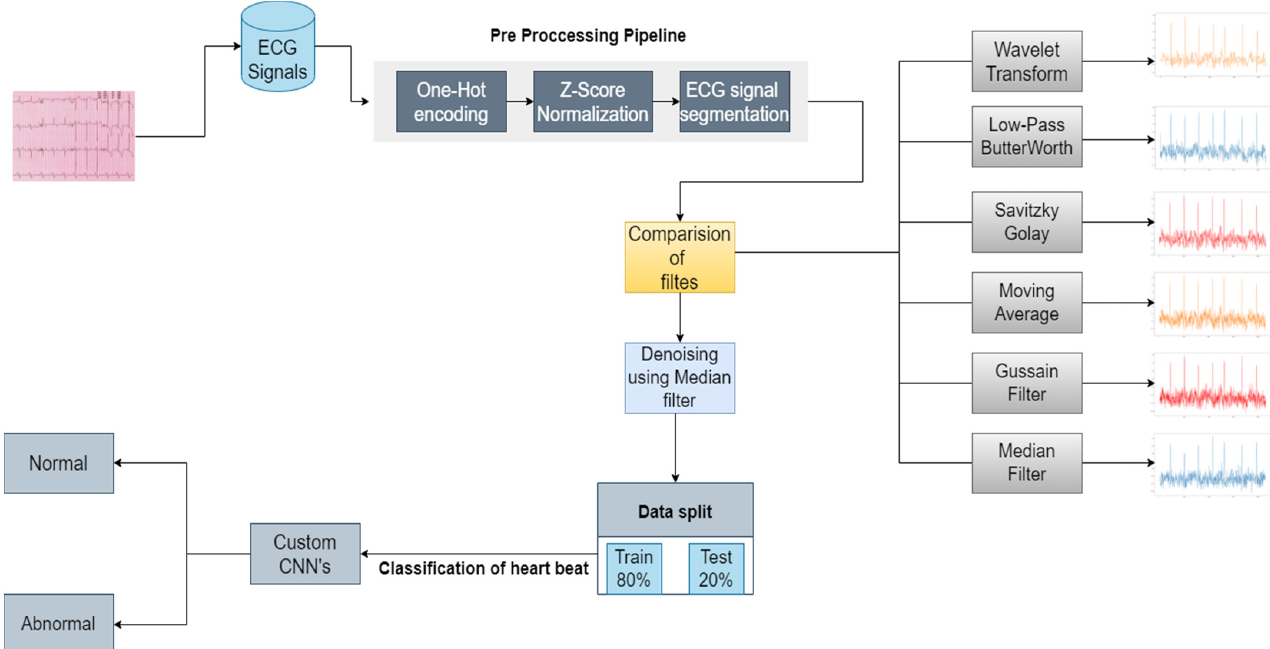
Figure 5. Proposed methodology for the classification of a heartbeat using custom CCNNs.